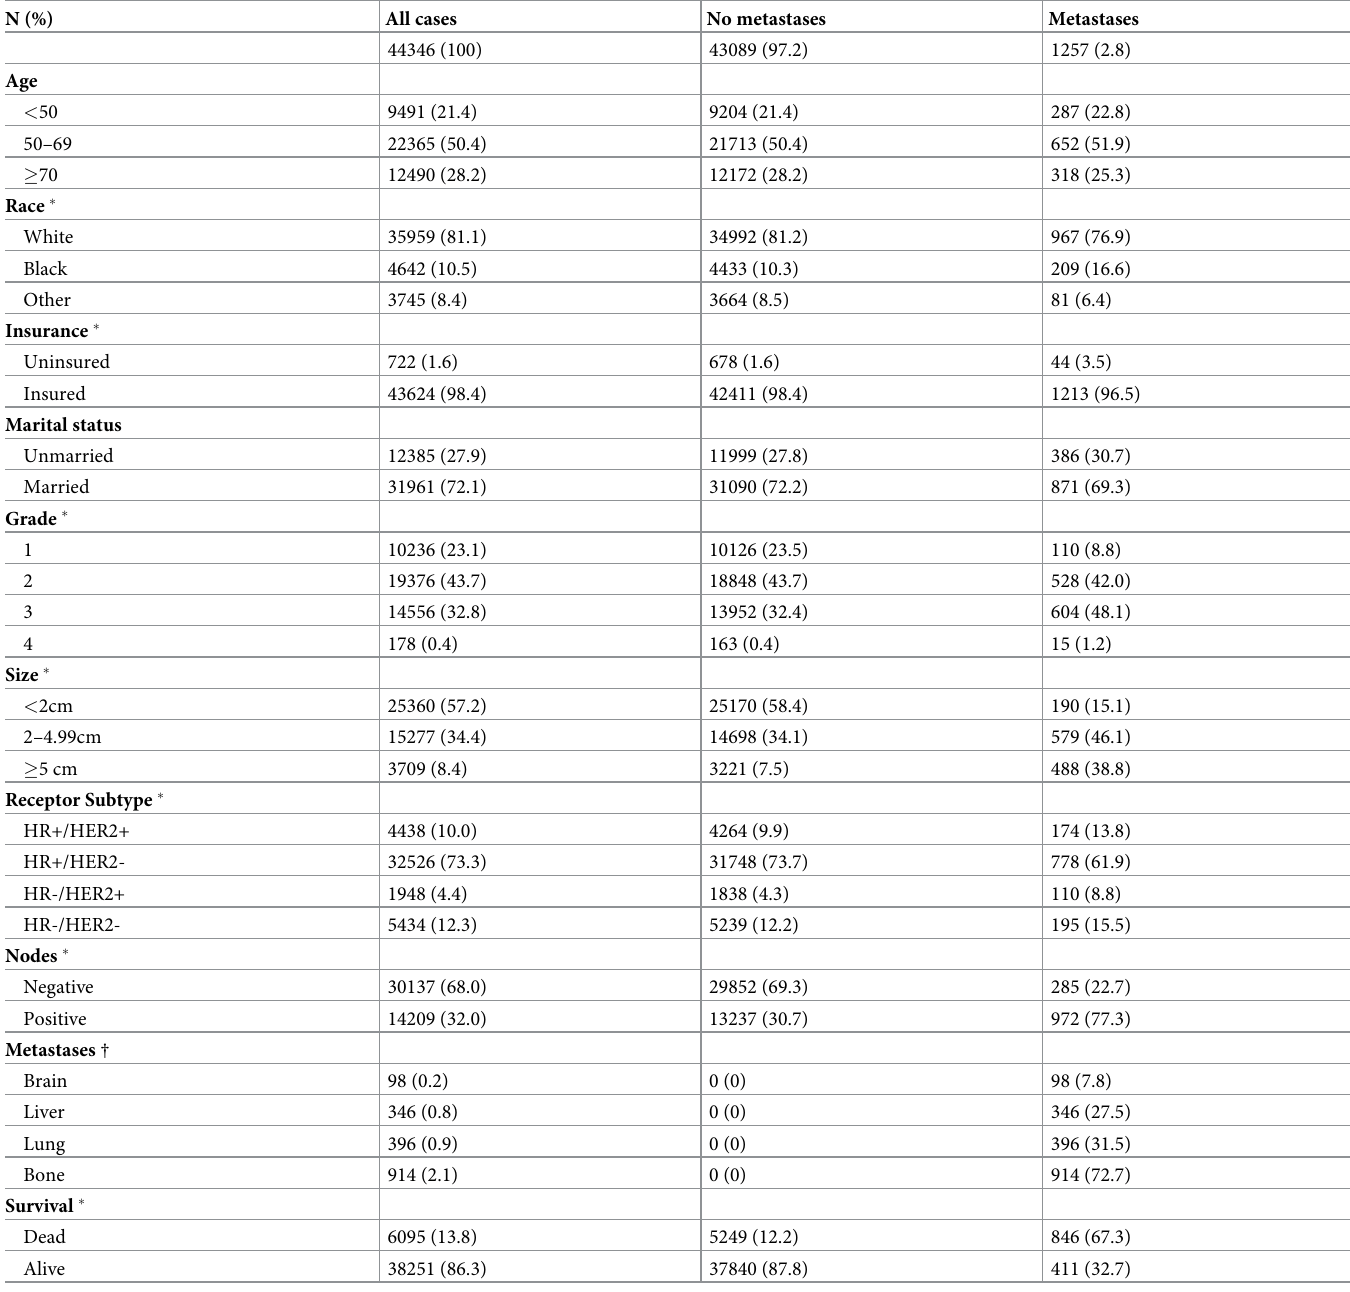
Table 1. Demographics of the final